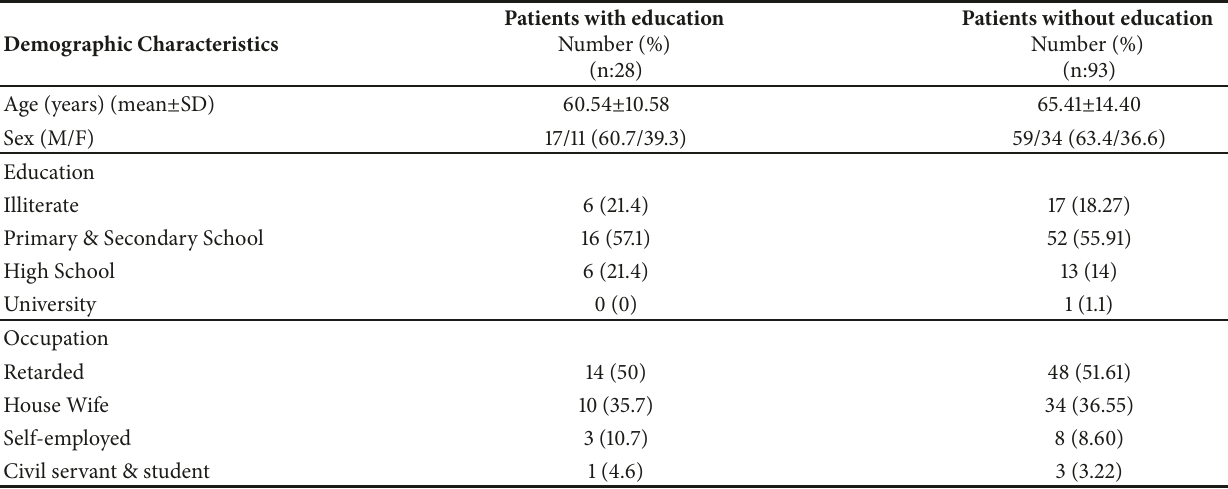
Table 1: Demographic characteristics of the patients with cardiac implantable electronic